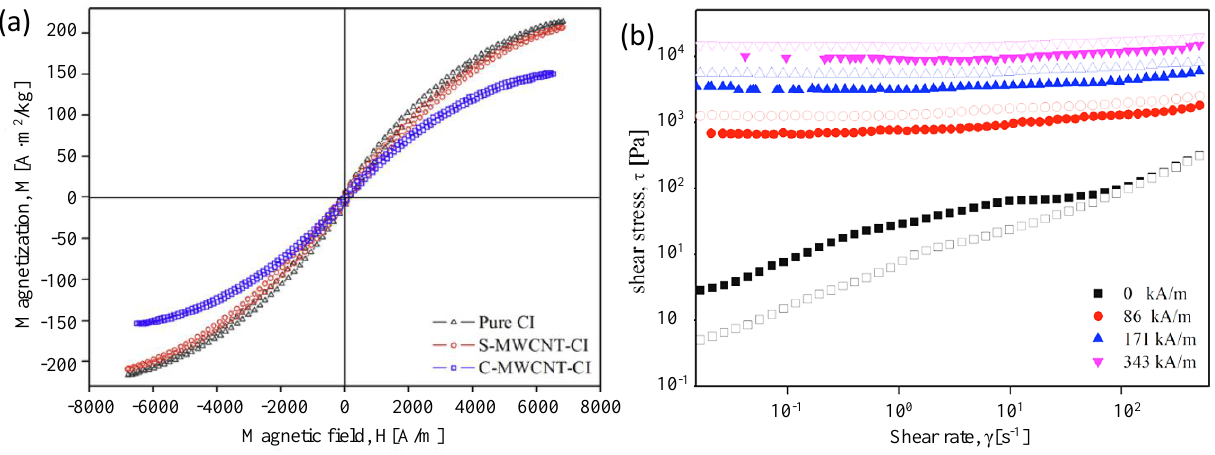
Figure 3. ( a ) VSM (Vibrating Sample Magnetometry) curves obtained from the pure CI, S-MWCNT-CI, and C-MWCNT-CI particles; ( b ) shear stress curves obtained from the C-MWCNT-CI (closed) and pure CI (open) particles-based MR suspensions [37]. (Reproduced with permission from Colloids & Surfaces A: Physicochemical and Engineering Aspects , published by Elsevier,